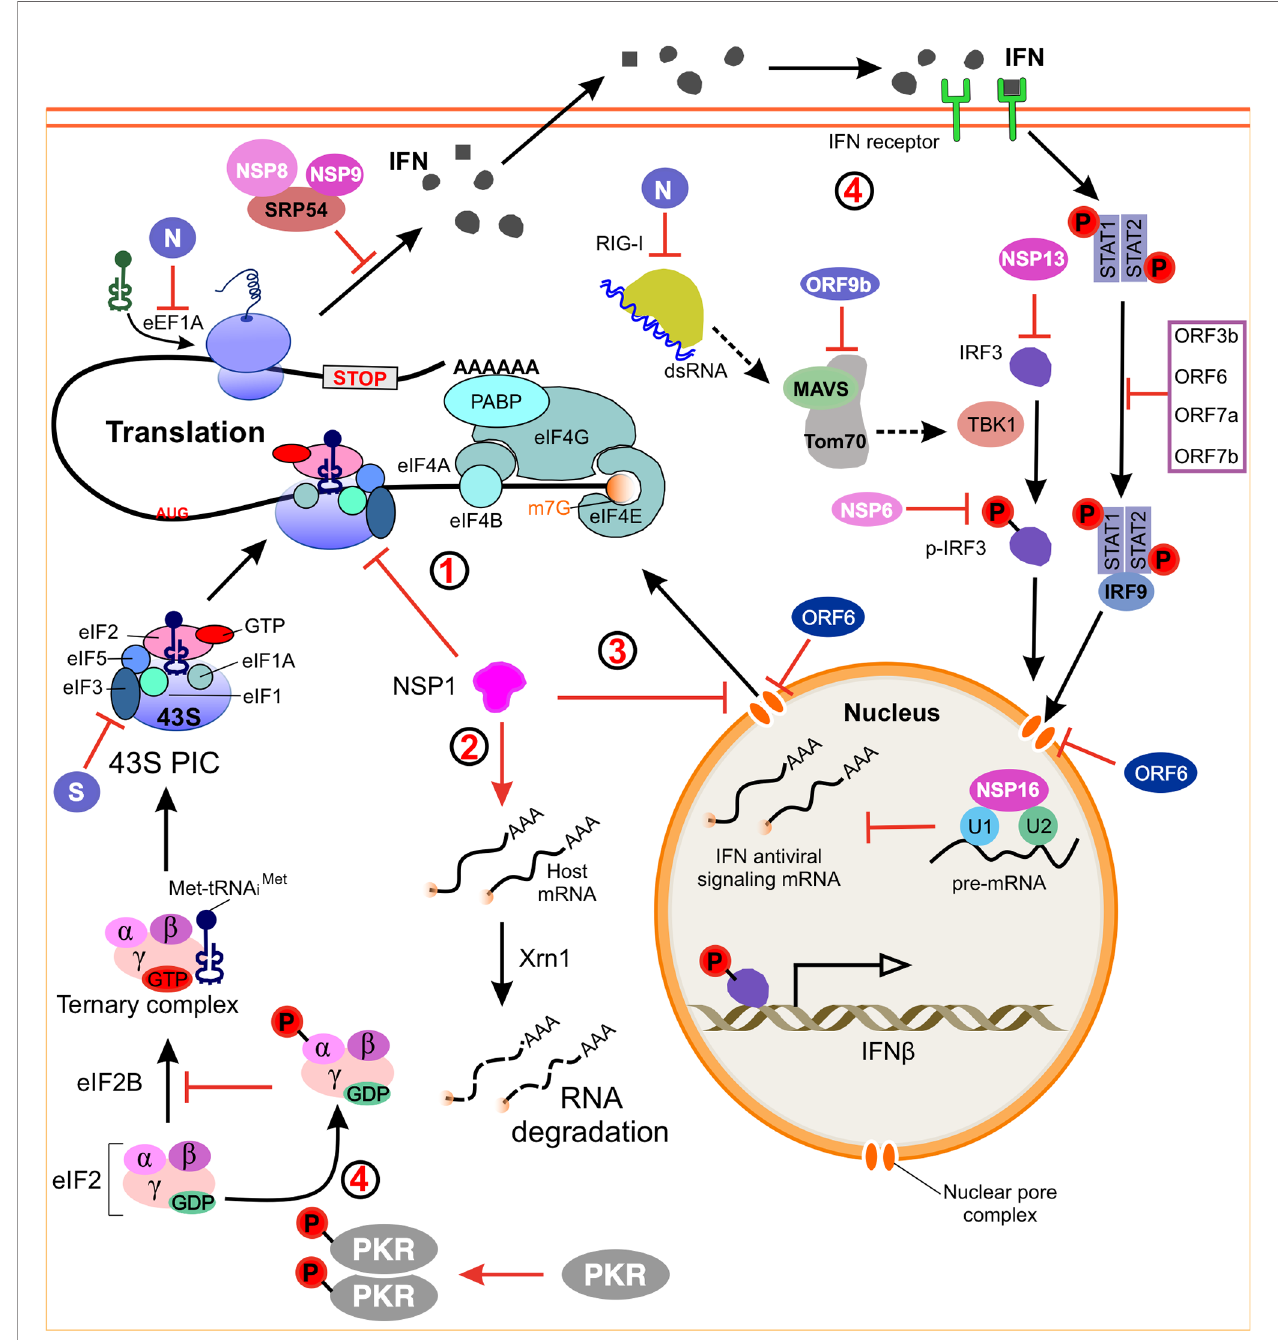
FIGURE 3 | Model of SARS-CoV-2 regulating host gene expression. (1) NSP1 binds to the 40S ribosomal subunit and blocks mRNA entry channels, thereby blocking global mRNA translation. (2) NSP1 induces endonucleolytic cleavage and subsequent degradation of host mRNA via the Xrn1-mediated 5 ’ -3 ’ exonucleolytic mRNA degradation pathway, and these activities are dependent on binding of NSP1 to 40S ribosomes. (3) Inhibition of nuclear mRNA export. NSP1 interacts with the host mRNA export receptor to inhibit nuclear export of cellular mRNA. ORF6 alters the nuclear pore complex by interacting with the export complex thereby preventing the bidirectional translocation of cellular mRNAs. (4) A model how SARS-CoV-2 suppresses host immune responses. NSP1, NSP16, N, ORF6 and ORF9b antagonize the host ’ s antiviral response and allow the virus replication robustly. SARS-CoV-2 induced activation of PKR inhibits the initiation of eukaryotic translation by phosphorylating the IF2 a . dsRNA, double-stranded RNA; IFN, interferon; IRF3, interferon regulatory factor 3; MAVS, mitochondrial antiviral signaling protein; Tom70, outer mitochondrial membrane protein 70; TBK1, TANK-binding kinase 1; STAT1, signal transducer and activator of transcription 1; PKR, protein kinase receptor; eIF2, a subunit of initiation factor 2; SRP54, signal recognition particle 54; RIGs, interferon-stimulated